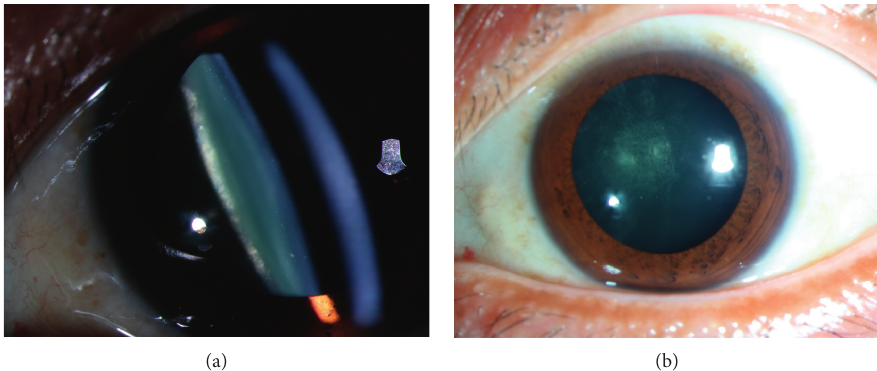
Figure 2: Example of a patient with posterior subcapsular cataract (PSC) in retinitis pigmentosa. (a) Opacification in slit-lamp image of lateral posterior capsular. (b) Holistic picture of PSC appearing as minor lens opacity in the central part of the posterior pole.